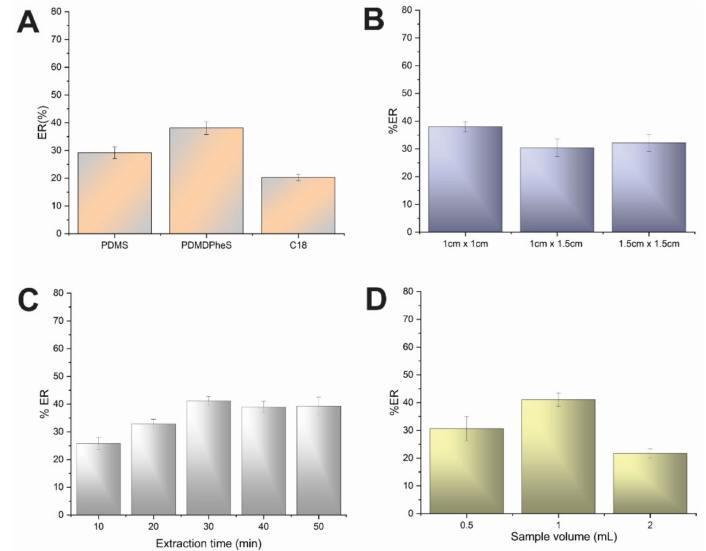
Figure 1. Effect of ( A ) FPSE sorbent type, ( B ) FPSE membrane size, ( C ) extraction time and ( D ) sample volume on %ER of AMTB ( n =